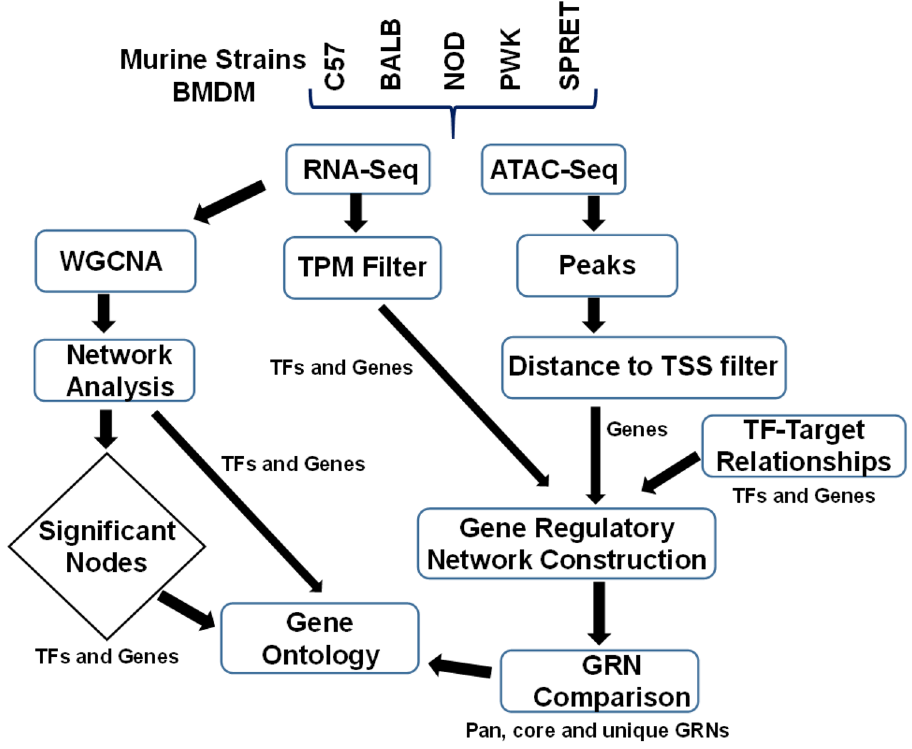
Figure 1. Integrative multi-omics pipeline to model the unstimulated bone marrow-derived macrophage (BMDM) putative gene regulatory networks (GRNs) in five genetically defined murine